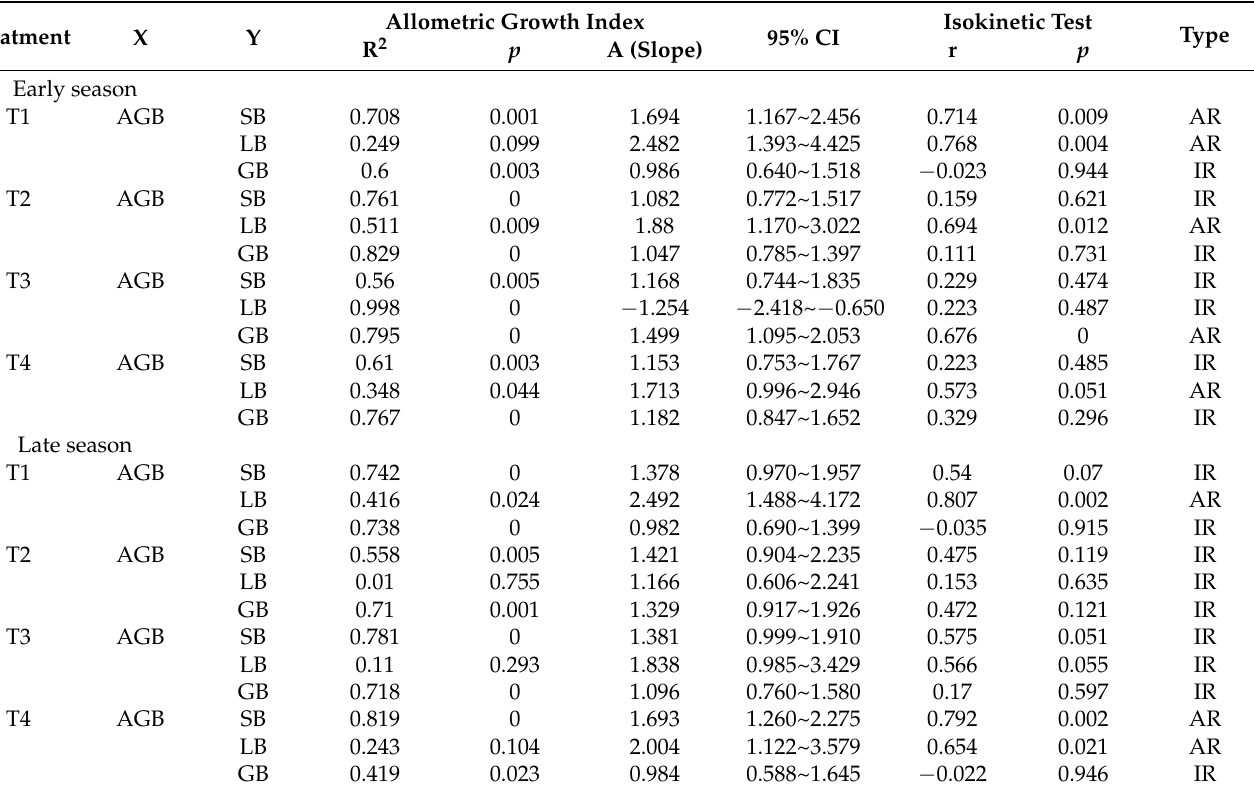
Table 5. Test of allometric growth between organ biomass in early and late season rice . Allometric Growth Index Treatment X Y